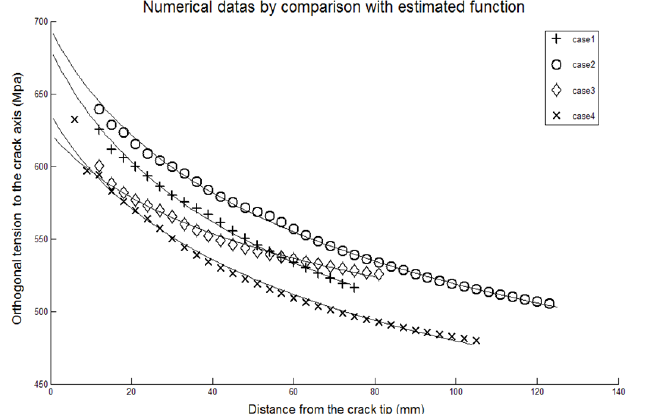
Figura 7: Confronto tra i dati delle simulazioni FEM e fitting della funzione